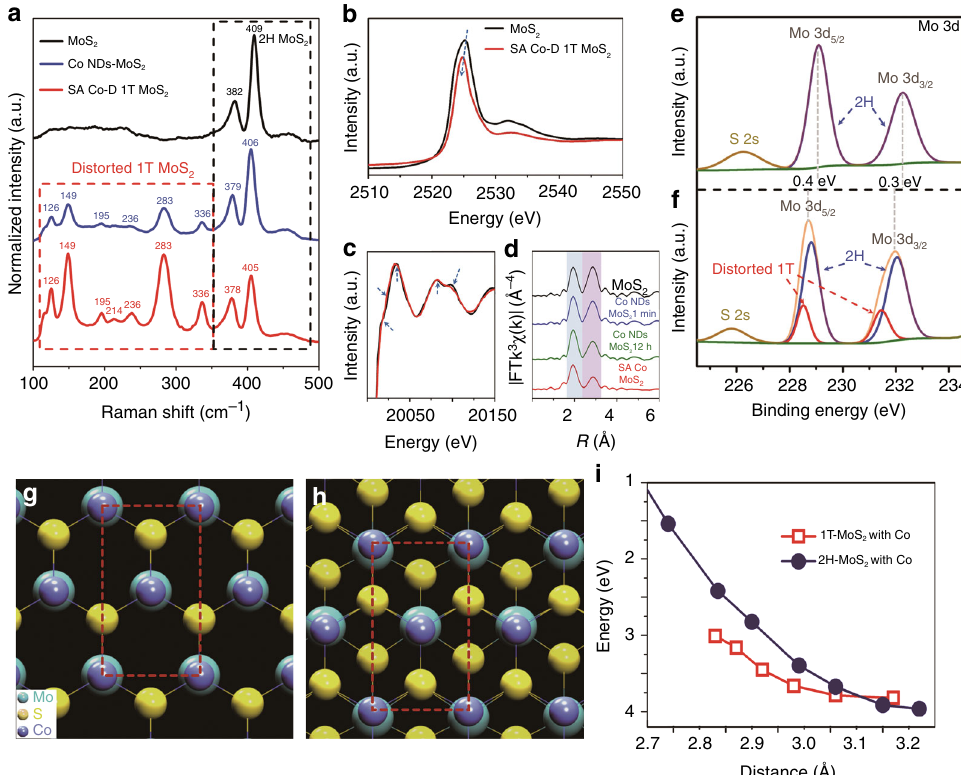
Fig. 2 Characterization techniques and DFT calculation for the phase transformation of MoS 2 . a Raman spectra of pristine MoS 2 , Co NDs/MoS 2 , and SA Co-D 1T MoS 2 . b , c Mo L 3 -edge and K-edge XANES spectra of SA Co-D 1T MoS 2 and pristine MoS 2 . d Mo K-edge EXAFS spectra variation during the preparation of SA Co-D 1T MoS 2 . e , f Mo 3d XPS spectra show the surface-binding state variation before e and f after the MoS 2 phase transformation. g 2H and h 1T atomic structures of MoS 2 assembled with Co atomic layer calculated by fi rst-principles. i Energies of 2H MoS 2 and 1T MoS 2 assembled with Co atomic layer as a function of Co – Co distance calculated by fi rst-principles method based on the single layer 2H MoS 2 and atomic Co as the reference state with the formula Δ E = E 2H-MS + E Co — E